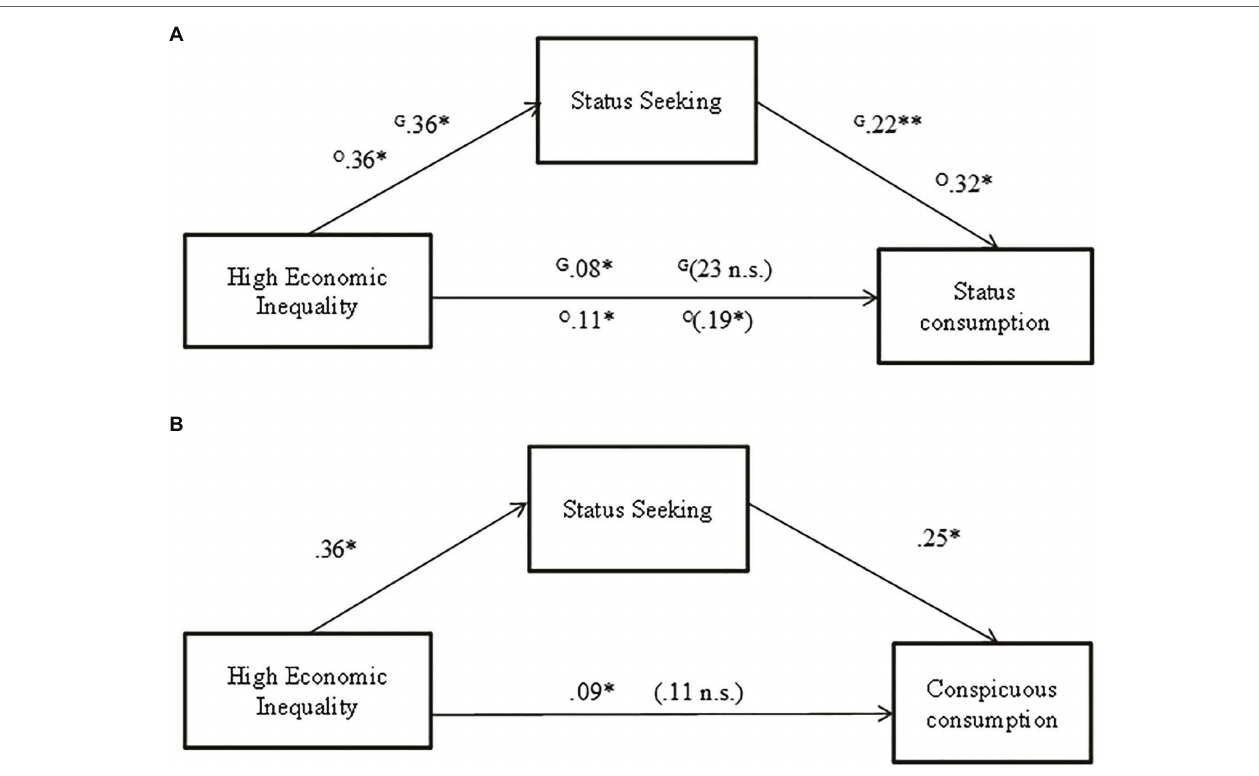
FIGURE 4 | Indirect effect of perceived economic inequality condition on status consumption (A) and conspicuous consumption (B) through status seeking in Study 2. (A) Shows the coefficients for the two measures of status consumption used. Coefficients (standardized) of the mediation with Griskevicius et al. (2007) status consumption scale are identified with a G, and coefficients (standardized) of the mediation with status consumption scale based on the factors O’Cass and McEwen (2004) are identified with a O; total effect in parenthesis; * p < 0.05; ** p <